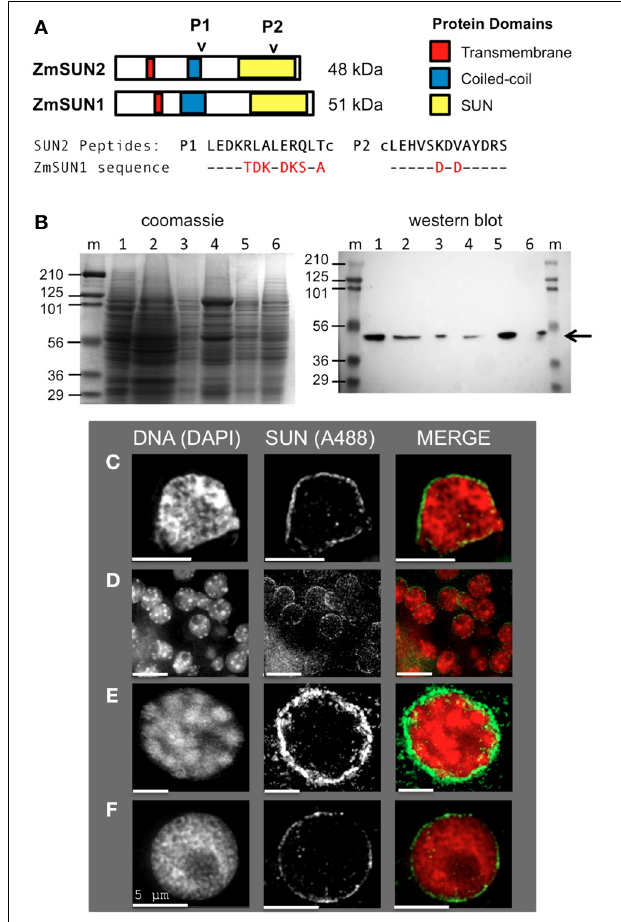
FIGURE 1 | Expression and localization of the maize CCSD class of SUN proteins in somatic tissues. (A) Generation of two synthetic peptides (SUN2-P1 and SUN2-P2, arrowheads) for immunolocalization of the endogenous CCSD class of maize SUN proteins ZmSUN2, and ZmSUN1 is shown. Peptide alignments for SUN1 and SUN2 are indicated, with divergent residues highlighted in red. Putative protein domains based on prediction algorithms are indicated (colored boxes). Lowercase cysteine (“c”) residues were synthetically added for affinity purification. (B) Immunological detection of endogenous SUN proteins in maize somatic cells from a variety of maize organs; Lanes (1) meiotic tassel primordia, (2) emerged tassel, (3) earshoot, (4) leaf, (5) husk, (6) silk, (m) marker lanes for protein size (kDa, indicated at left) standards. Total proteins from equal fresh-weight plant material were fractionated on duplicate gels, one for SDS-PAGE gel followed by Coomassie staining (left panel) and the other for western analysis (right panel). The arrow indicates a single detectable species smaller than 56kDa. (C–F) Protein immunolocalization using antisera indicated from (C) isolated earshoot nuclei, (D) somatic nuclei from cryo-sectioned whole anthers, (E) somatic prophase nuclei from isolated meiotic anthers and (F) pre-meiotic interphase nucleus. DAPI (total DNA, red) and A488 (SUN, green) are indicated in the merged 2D projections of the 3D data sets. Scale bars = 5 μ